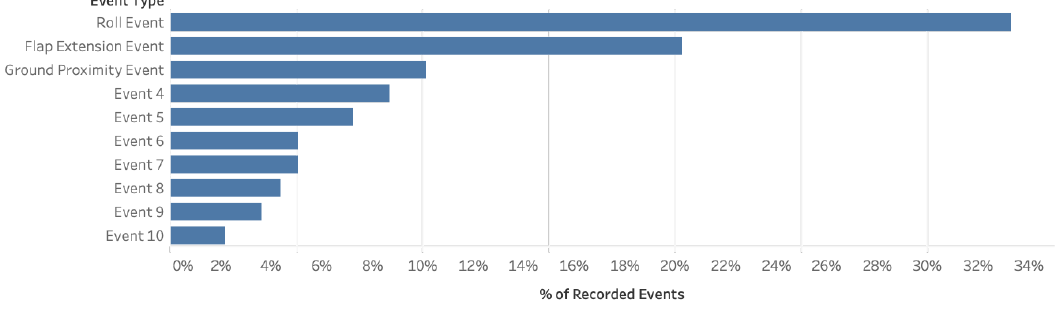
Figure 5. Flight-phase-based analysis showing the frequency of events for each event type.